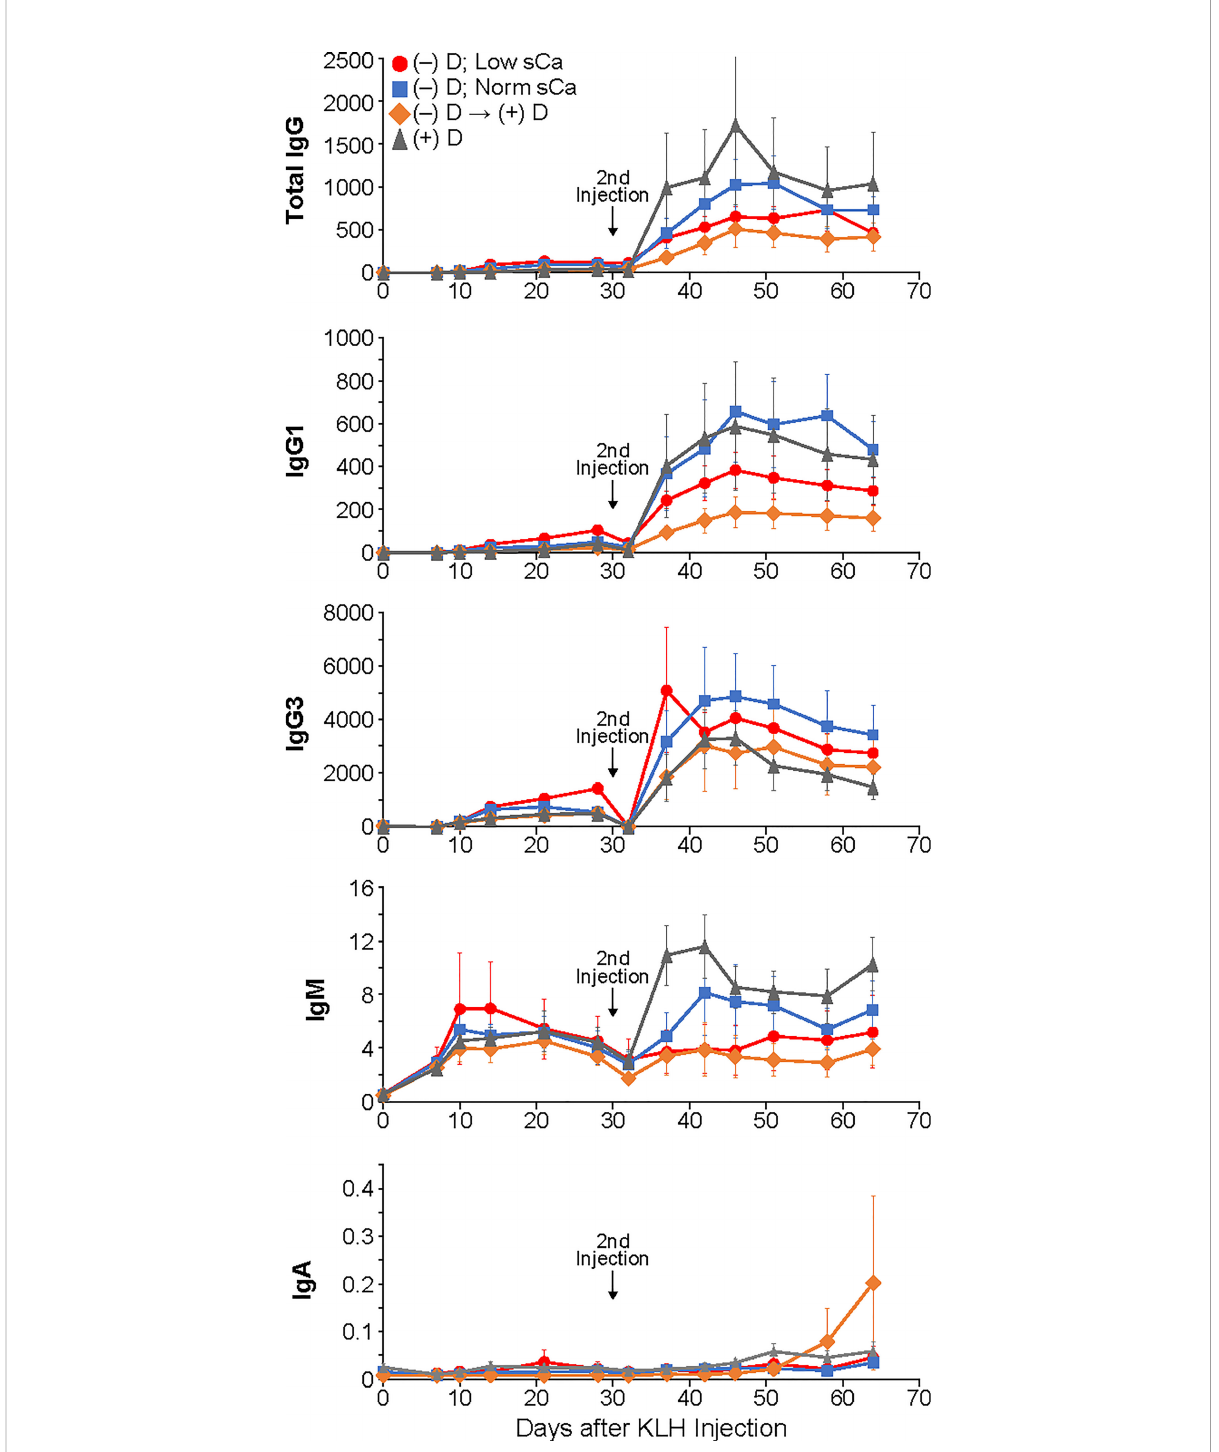
FIGURE 1 Primary and secondary antibody responses for Isotypes IgG, IgM and IgA and subclasses IgG1 and IgG3 in mice made vitamin D-de fi cient through dietary means. Statistical analyses were done as described in the Methods with only a few minor differences detected as noted in the text. The error bars are